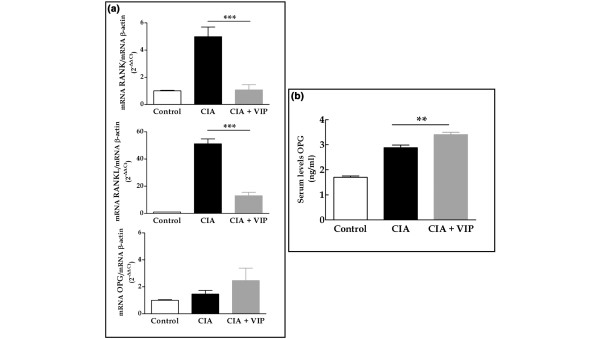
Vasoactive intestinal peptide (VIP) modulates the pattern of expression of the RANK/RANKL/OPG system in joints from mice with collagen-induced arthritis (CIA). (a) Expression of mRNA for receptor activator of nuclear factor-κB (RANK), receptor activator of nuclear factor-κB ligand (RANKL) or osteoprotegerin (OPG) in the hind paws was measured by quantitative real time PCR and corrected by mRNA expression for β-actin in each sample (see Materials and methods). (b) Serum levels of OPG in control, CIA or VIP-treated CIA mice were determined by ELISA. On day 10 of VIP treatment, differences between the arthritic group and the CIA group treated with VIP were statistically significant (**p < 0.01, ***p < 0.001). Results are the mean ± SEM of two independent experiments with 10 animals per group